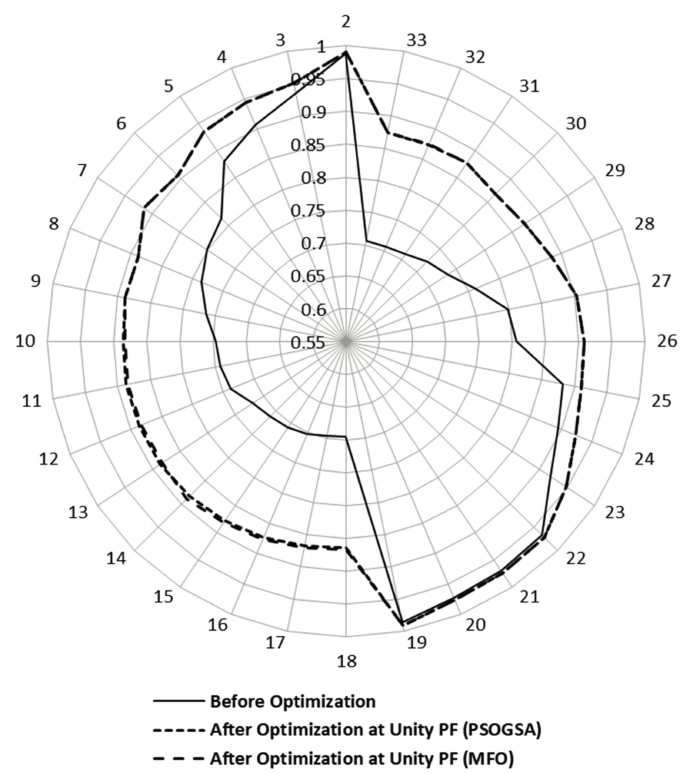
Figure 16. The impact of compensated devices on VSI profile for 33-bus IEEE system at unity PF.